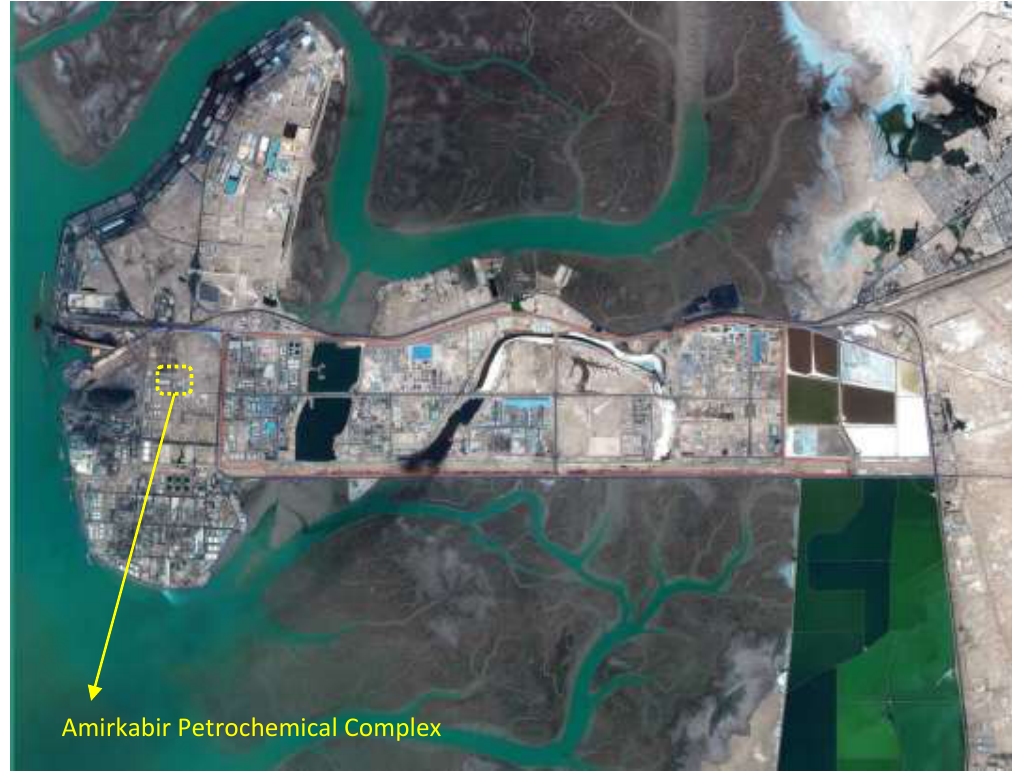
Figure 1: location of Amirkabir petrochemical zone in especial economic petrochemical